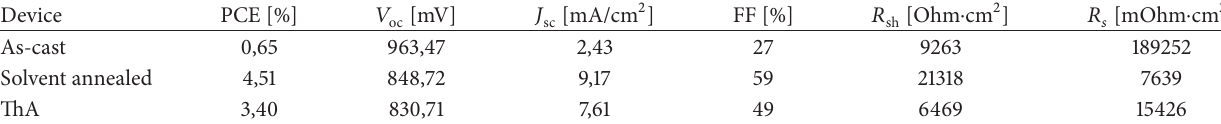
Table 1: Main photovoltaic parameters of as-cast, solvent annealed (THF for 4 s), and thermally annealed (110 ∘ C for 10min) devices. Device